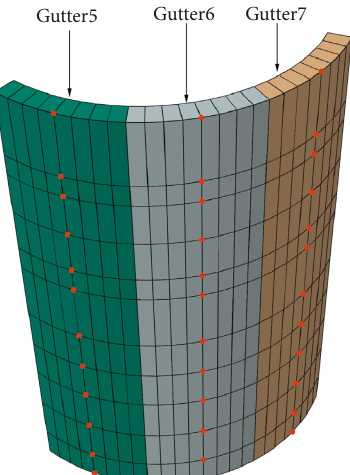
Figure 8: Selected element for lateral stress